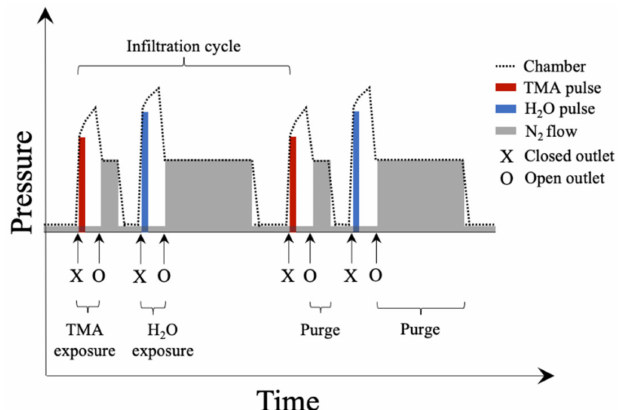
Figure 1. Schematic illustration of chamber pressure as a function of time in semi-static sequential infiltration synthesis (SIS). Not to scale. Adapted with permission from [10], copyright 2021 the Authors. Published by ACS